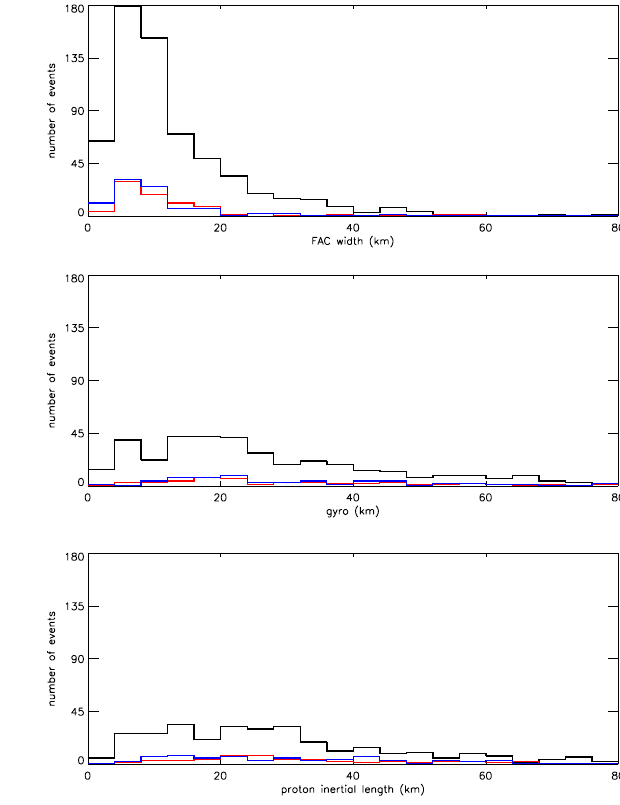
Fig. 1. The number of events versus S(E) , S(dn) , and S( FAC ) , black lines represent monopolar events while red and blue lines rep- resent converging and diverging bipolar events, respectively.